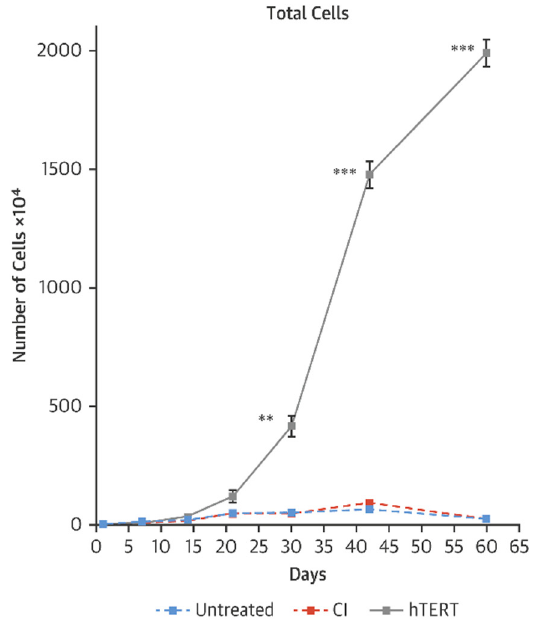
Figure 2. Growth curves of HGPS fibroblasts after 3 treatments with vehicle, transfected HGPS fibroblasts with human telomerase (TERT) or catalytically inactive (CI) TERT mRNA [59]. ** p < 0.01; *** p < 0.001.